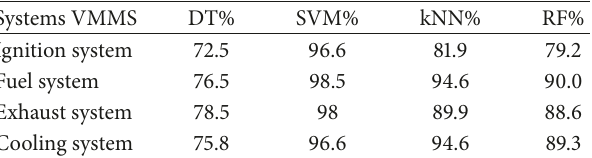
Table 5: Comparison with existing